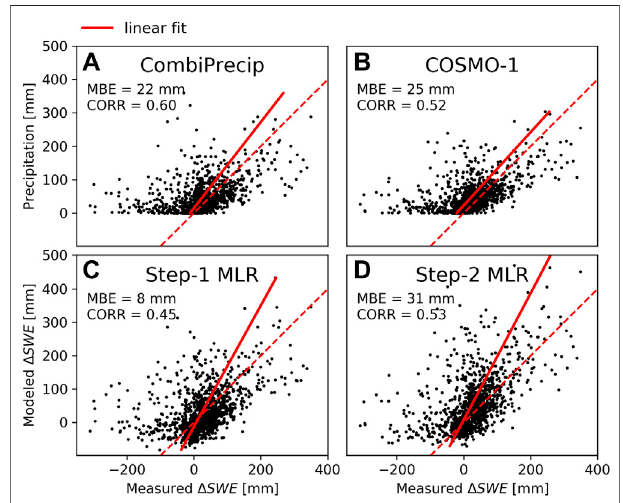
FIGURE 10 | The twice-monthly SWE measurements on 44 non- glacierizedsitesandfourwinterseasonscomparedwith (A) :CombiPrecip (B) : COSMO-1 (C) : Step-1 MLR (D) : Step-2